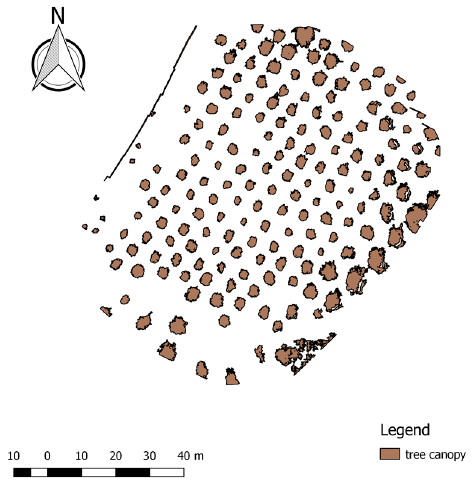
Figure 6. Shapefile with tree crown well identified.